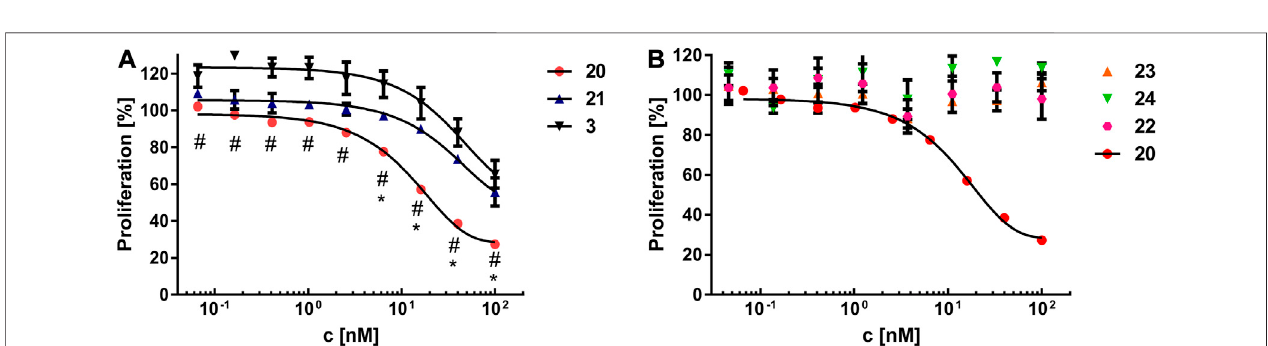
FIGURE 6 | (A) Cell proliferation assay of MMAE-functionalized constructs 20 , 21 , and 3 on U87MG cells. Results are displayed as mean ± standard error of the meanand arebasedontriplicates.Signi fi cantdifferences( p ≤ 0.05)between 20 and 21 or 20 and 3 aredepictedas(*)and(#),respectively. (B) Cellproliferationassayof constructs 20 , 22 , 23 , and 24 on U87MG cells. Results are shown as the mean ± standard error of the mean and are based on triplicates.